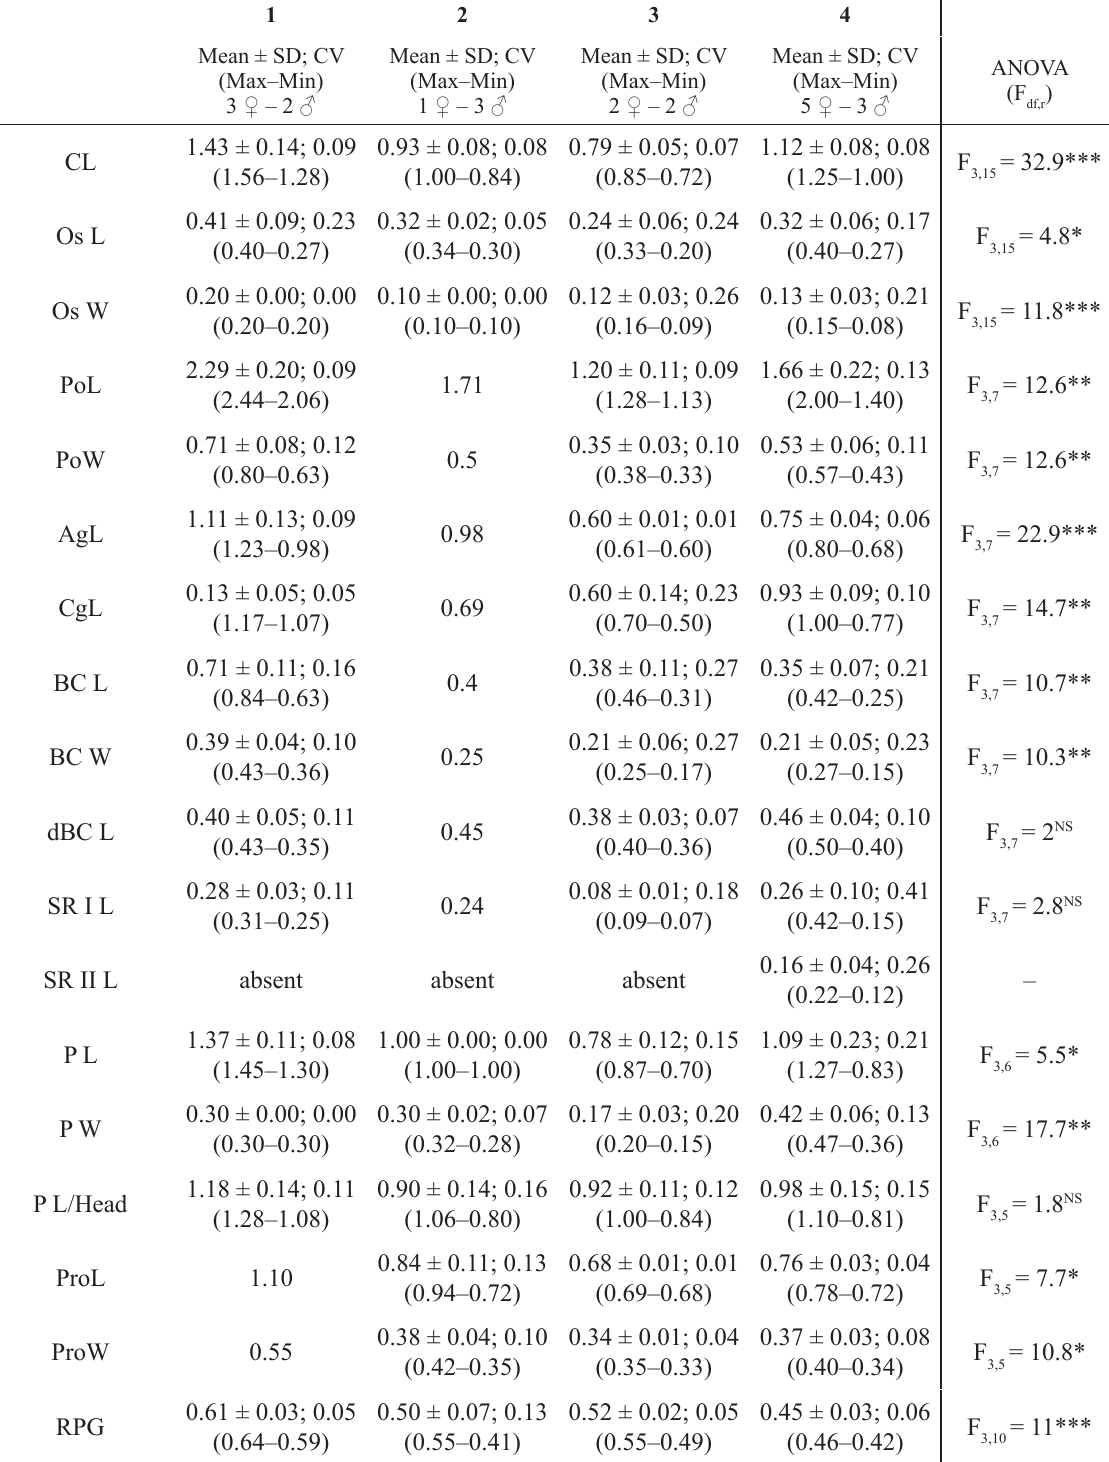
Table 3. Ctenidium, osphradium. Female and male genitalia and nervous system measurements (in mm) of the species: 1 . Intermaria zagrosensis (Glöer & Pešić, 2009). 2 . Intermaria kermanshahensis (Glöer & Pešić, 2009). 3 . Persipyrgula saboori (Glöer & Pešić, 2009). 4 . Shadinia terpoghassiani (Shadin, 1952). For ANOVA results effect size F, degrees of freedom (df), residuals (r) and the resulting